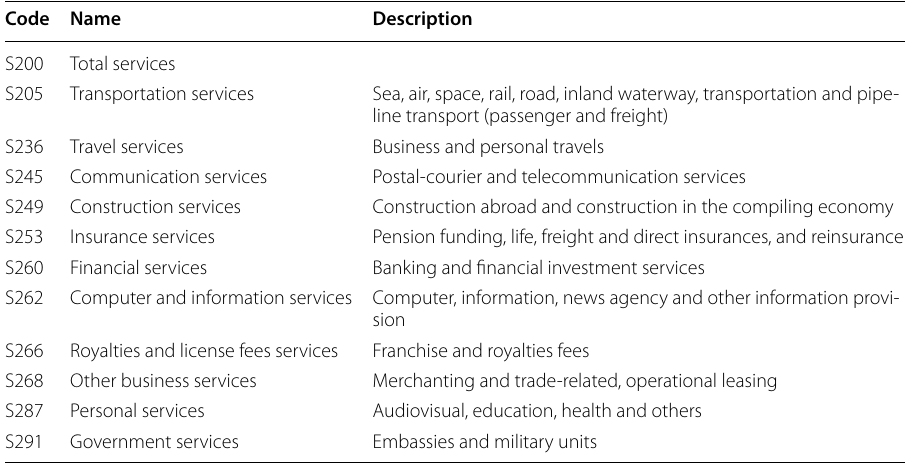
Table 1 The 11 EBOPS service categories S205 to S291 as reported by BaTis. The first one, Total services (S200), is the aggregate of all the